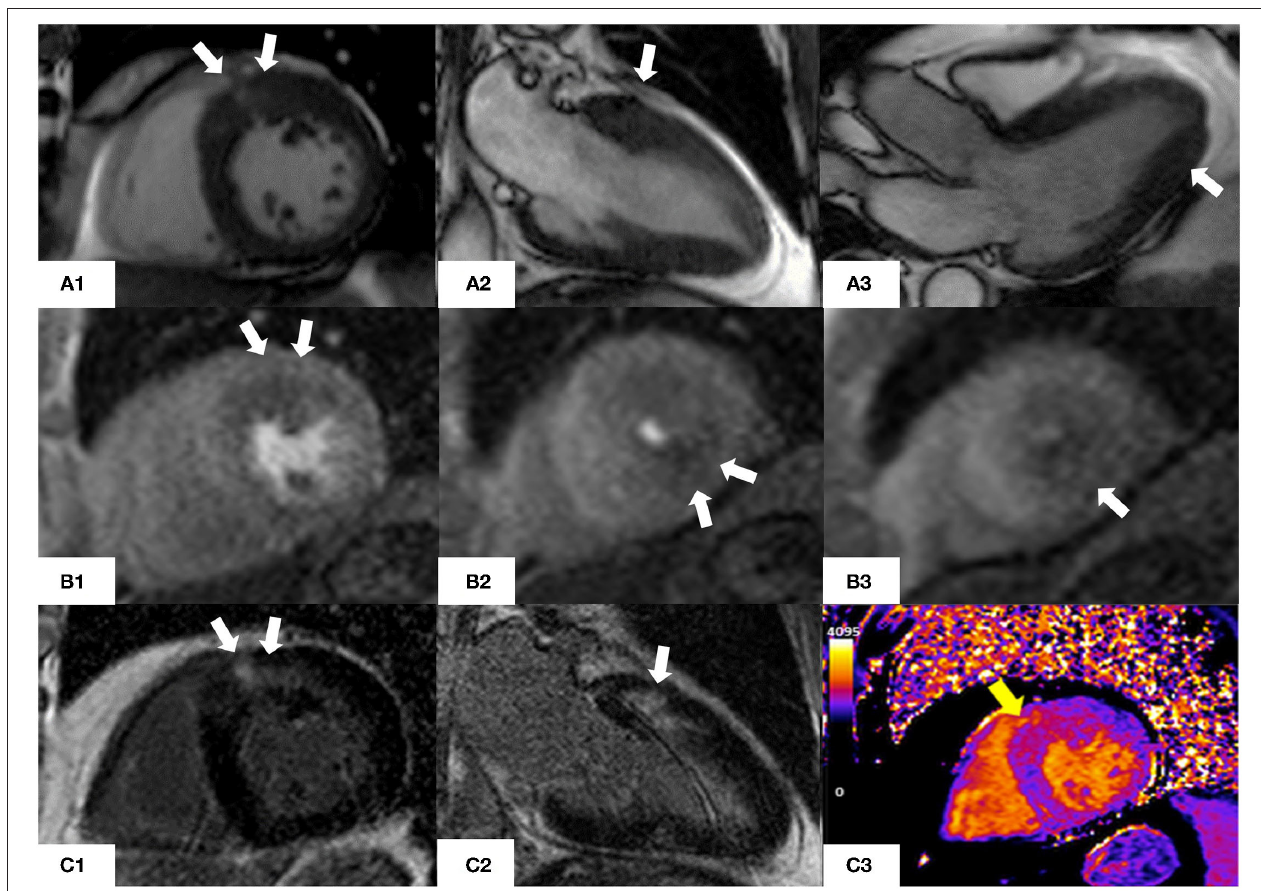
FIGURE 4 | CMR findings in a 76 year old man with asymmetric hypertrophic cardiomyopathy who presented with atypical chest pain and non-sustained ventricular tachycardia on a recent ECG-Holter. (A1–A3) Steady-state free precession sequence (SSFP) cine imaging showing asymmetrical hypertrophy of the basal anterior wall and mild apical hypertrophy (white arrows). (B1–B3) Stress perfusion images showing inducible microvascular dysfunction of the hypertrophic basal anterior wall and mid-cavity and apical inferior wall (white arrows). (C1, C2) Late gadolinium enhancement imaging (LGE) showing patchy myocardial fibrosis of the hypertrophied segments (white arrows). (C3) Native T1 mapping (basal short axis view). Increased native T1 values (yellow arrow) in the basal anterior and basal anteroseptal walls (1,170 msec, normal range 1,000 ± 50 msec) matching the patchy LGE noted in panels (C1, C2)